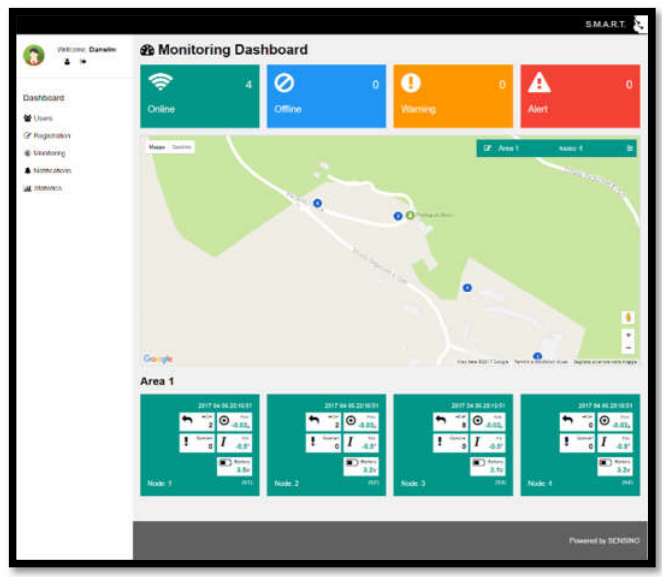
Figure 13. Graphical web interface for system monitoring and data analysis.